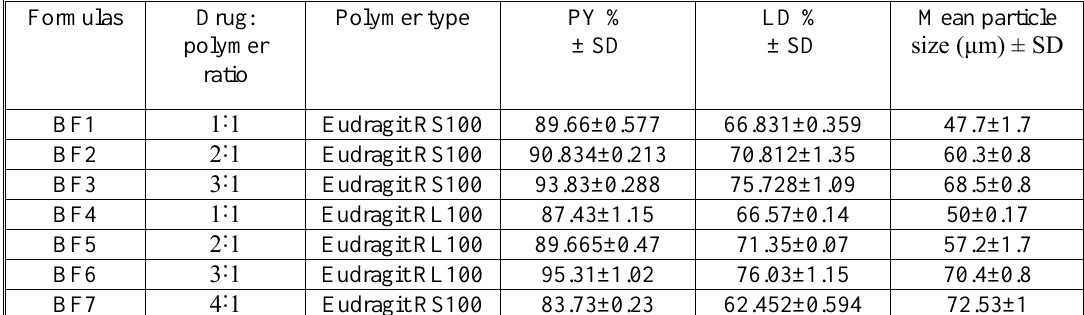
Further increase in drug to polymer ratio have reverse effect on both the PY and LD as shown in BF7, the reason for decrease in both the PY and LD with increasing drug to polymer ratio is due to the amount of polymer was not sufficient to encapsulate all amount of drug (29)